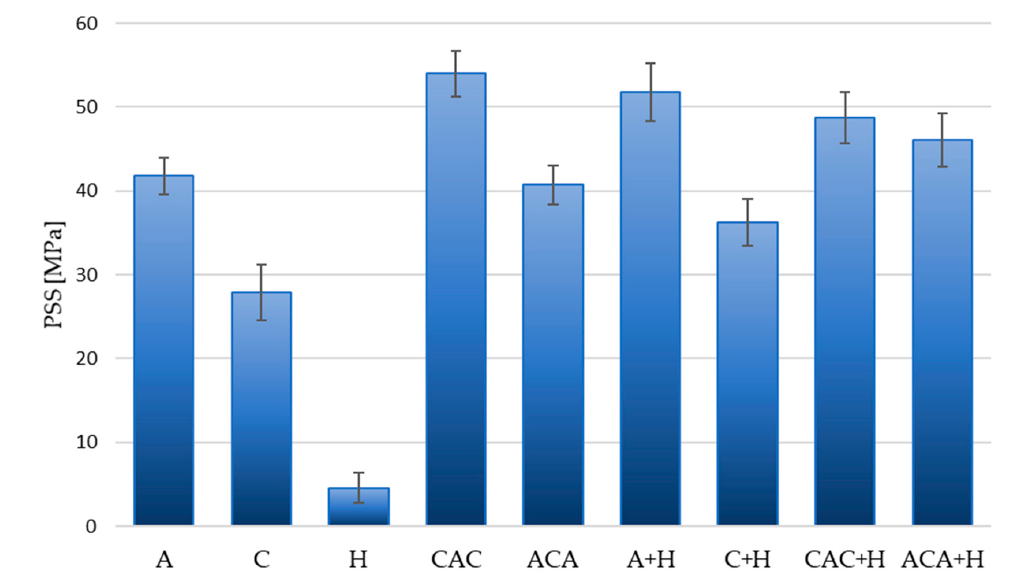
Figure 9. Punch shear stress distributions of laminates. Table 3. Comparison of QSPT results.